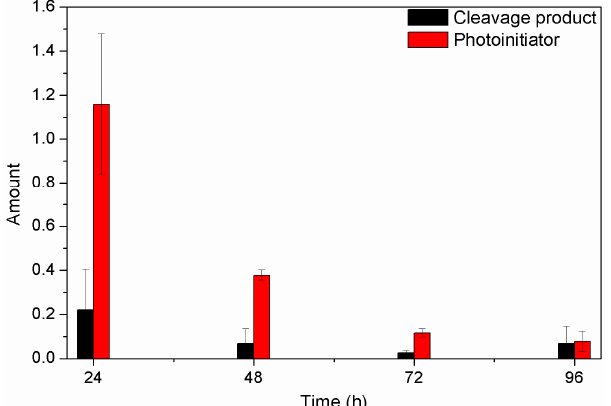
Figure 7. Chromatograms of photoinitiator and photo cleavage product in every washing solution taken after different time periods. The amount of residual compounds is related to the amount of the internal standard ethanol. Therefore, the area of the analyzed substances was divided by the peak area of ethanol.